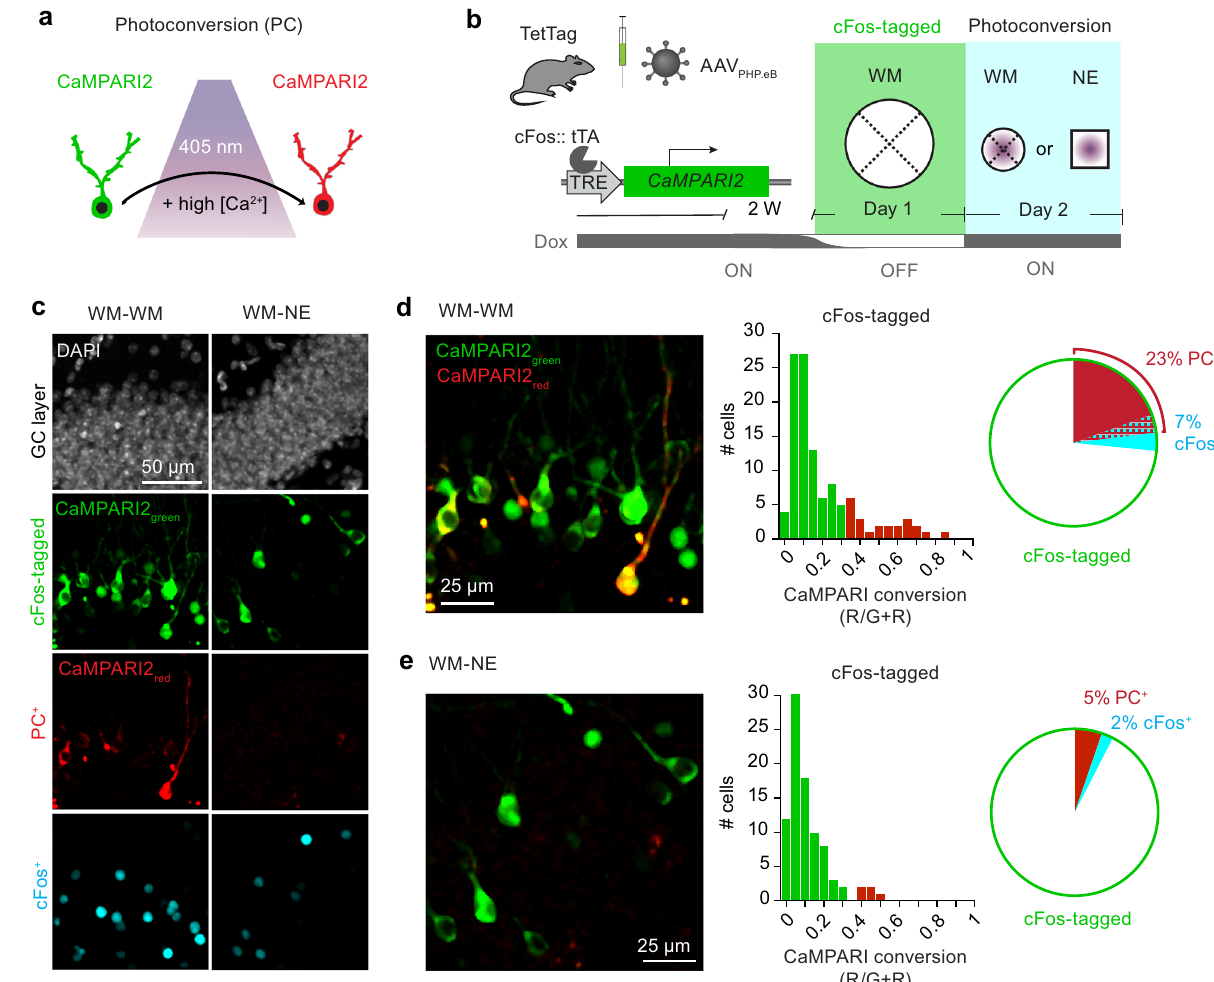
Fig. 4 | cFos-tagged dentate granule cells are reactivated during water maze training. a The calcium integrator CaMPARI2 is photoconverted by 405nm light (violet shading) only in neurons with high intracellular Ca 2+ . b Experimental time- line: TetTag mice were injected with AAV PHP.eB -TRE- CaMPARI2 and trained in the WMOFFDox(day1,cFostagging,greenshading).Onday2,photoconversionlight was applied to the DG during WM training or in a novel environment (NE, open fi eld). c Confocal images of DG. Gray is DAPI staining, green is cFos-dependent CaMPARI2 expression, red is immunostaining against photoconverted CaMPARI2 (PC + ), cyanis shEGFPimmunostaining (cFos + ) performed 90min after the last trial.